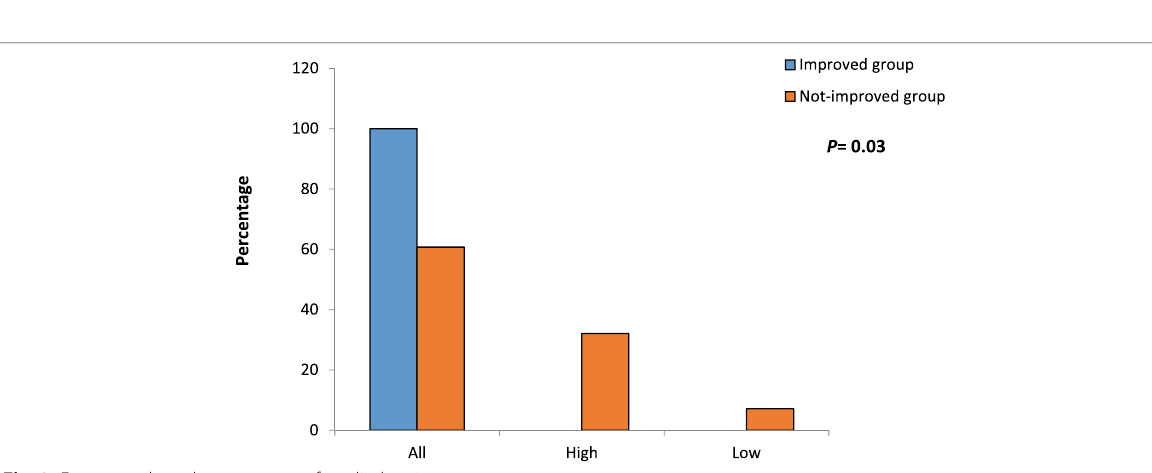
Fig. 3 Frequency based on outcome of studied patients